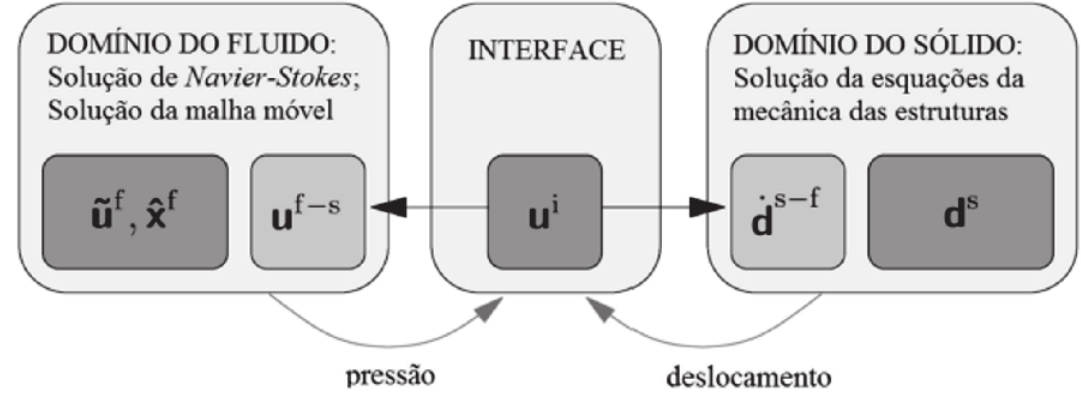
Esquema de resolução para o acoplamento